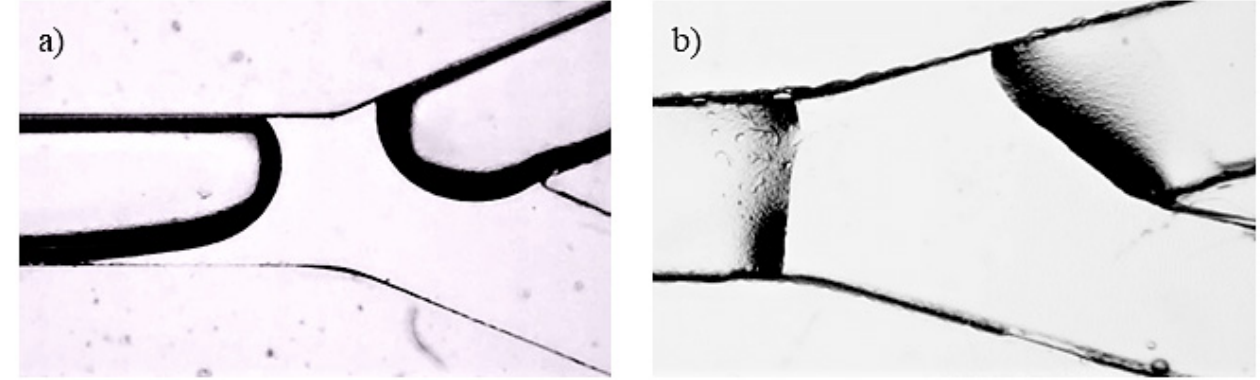
Figure 1. Influence on the water–wall contact of the polydimethylsiloxane (PDMS) time duration treatment in plasma: ( a ) 2.5 minutes; ( b ) 5 minutes.